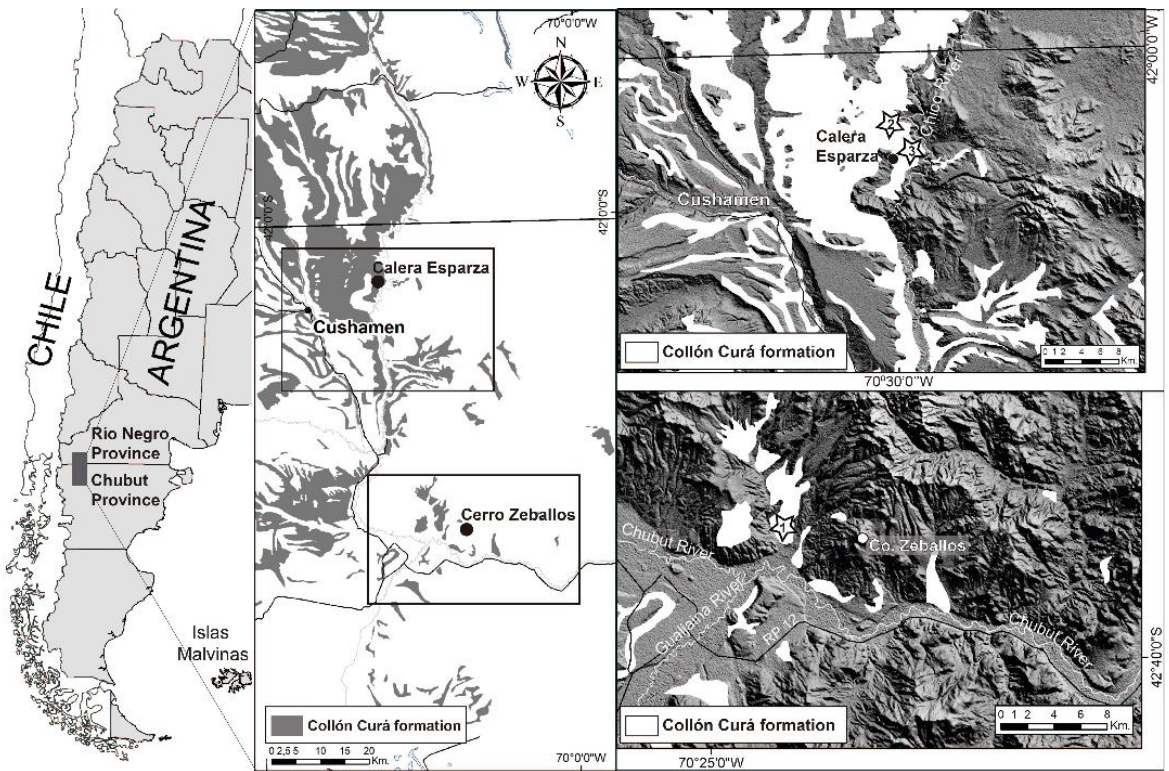
Figure 1. Map showing fossiliferous localities of Río Chico and Cerro